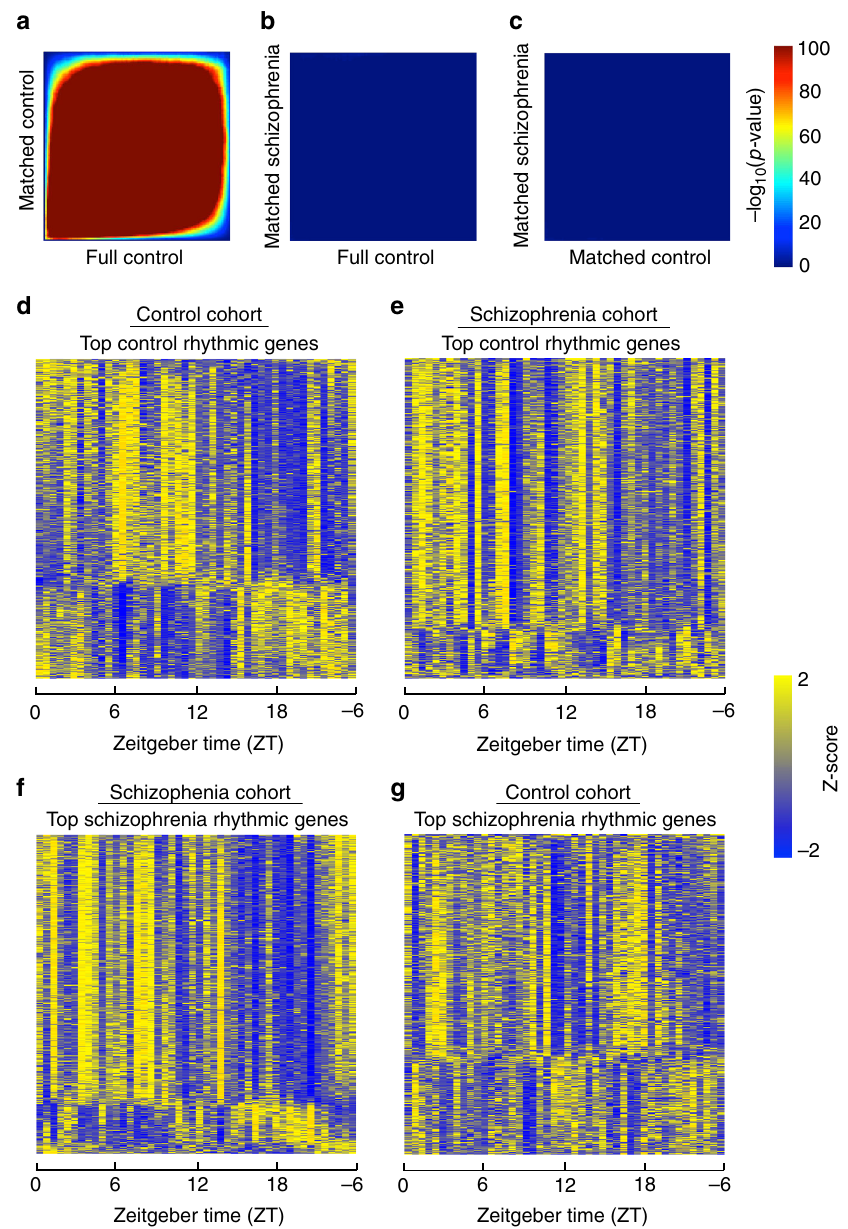
Fig. 2 Rhythmic genes are largely distinct in control subjects and subjects with schizophrenia. Nonlinear regression was used to detect circadian gene expression patterns based on individual TODs. Sinusoidal curves were fi tted using the nonlinear least-squares method and the coef fi cient of determination ( R 2 ) was used as a proxy of goodness-of- fi t. A null distribution of R 2 generated from 1000 TOD-randomized expression data sets was used to estimate the empirical p-value by comparing observed R 2 and the null distribution of R 2 . a RRHO plot indicating high degree of overlap in rhythmic genes between the full healthy control cohort and the matched control cohort. b RRHO plot indicating lack of overlap in rhythmic genes between the full healthy control cohort and the matched schizophrenia cohort. c RRHO plot indicating lack of overlap in rhythmic genes between the matched healthy control cohort and the schizophrenia cohort. d Heatmap for the circadian genes in the matched control cohort ( p < 0.05). Expression levels are Z-transformed for each gene, and the genes are ordered by their circadian phase value (peak hour). Each column represents a subject and the subjects are ordered by time of death. e Heatmap for the healthy control circadian genes in the schizophrenia cohort, indicating disrupted rhythmicity of normally rhythmic genes in subjects with schizophrenia. f Heatmap for the circadian genes in the matched schizophrenia cohort. g Heatmap for the schizophrenia circadian genes in the control cohort, indicating that these genes are not rhythmic in control